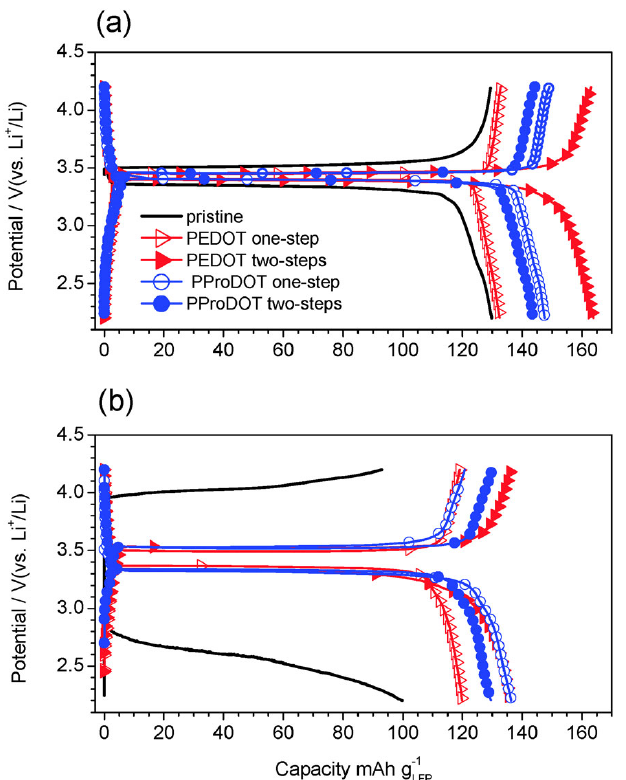
Figure 11. Charge–discharge plots for the different composites at ( a ) C/10 rate and ( b ) C rate [111]. Reprint with permission from [111]; Copyright 2014, Royal Society of Chemistry. Table 3. Synthetic strategies and electrochemical performance of lithium iron phosphate elec- trodes containing EAECPs as conductive binders.